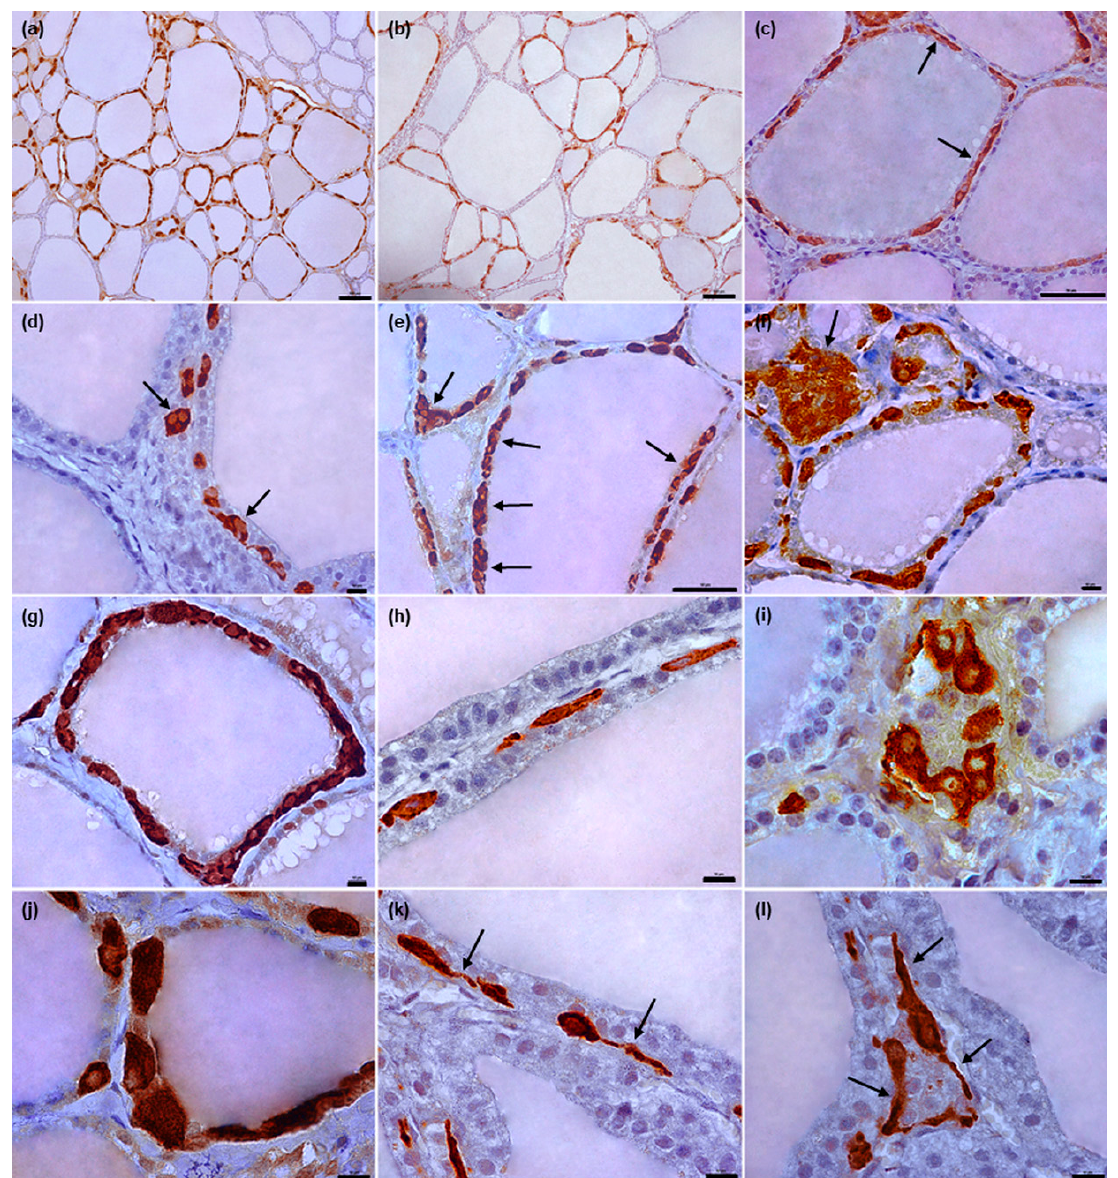
Figure 3. Representative images of equine C thyrocytes arrangement and morphology. ( a , b ): Typical distribution of C thyrocytes in thyroid parenchyma. ( c – g ): Typical arrangement of C thyrocytes in thyroid follicles: cells located separately or in “chains” ( c , arrows), in groups of various sizes ( d – f , arrows), and as a rim encompassing the whole follicle ( g ). ( h – j ): Typical morphology of C thyrocytes in horses. ( k , l ): C cells with slender endings of cytoplasm (arrows). Immunoperoxidase staining with anti-calcitonin antibody, scale bars: ( a , b ) = 100 µm, c , e = 50 µm, ( d , f – l ) = 10 µm.